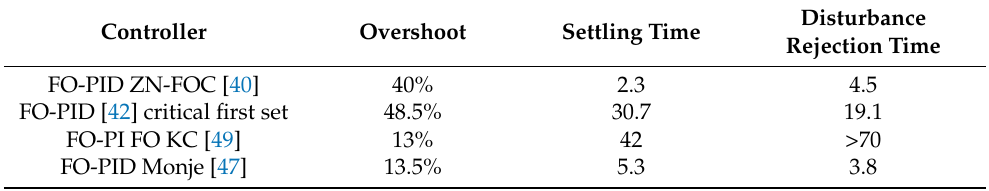
Figure 15. ( a ) Output signals for FO-PID control of integrative time-delay process. ( b ) Input signals for FO-PID control of integrative time-delay process required for setpoint tracking. ( c ) Input signals for FO-PID control of integrative time-delay process required for disturbance rejection. Controllers tuned according to [40,42,47,49]. Table 7. Closed-loop results obtained with the FO-PID controller for the integrative time-delay